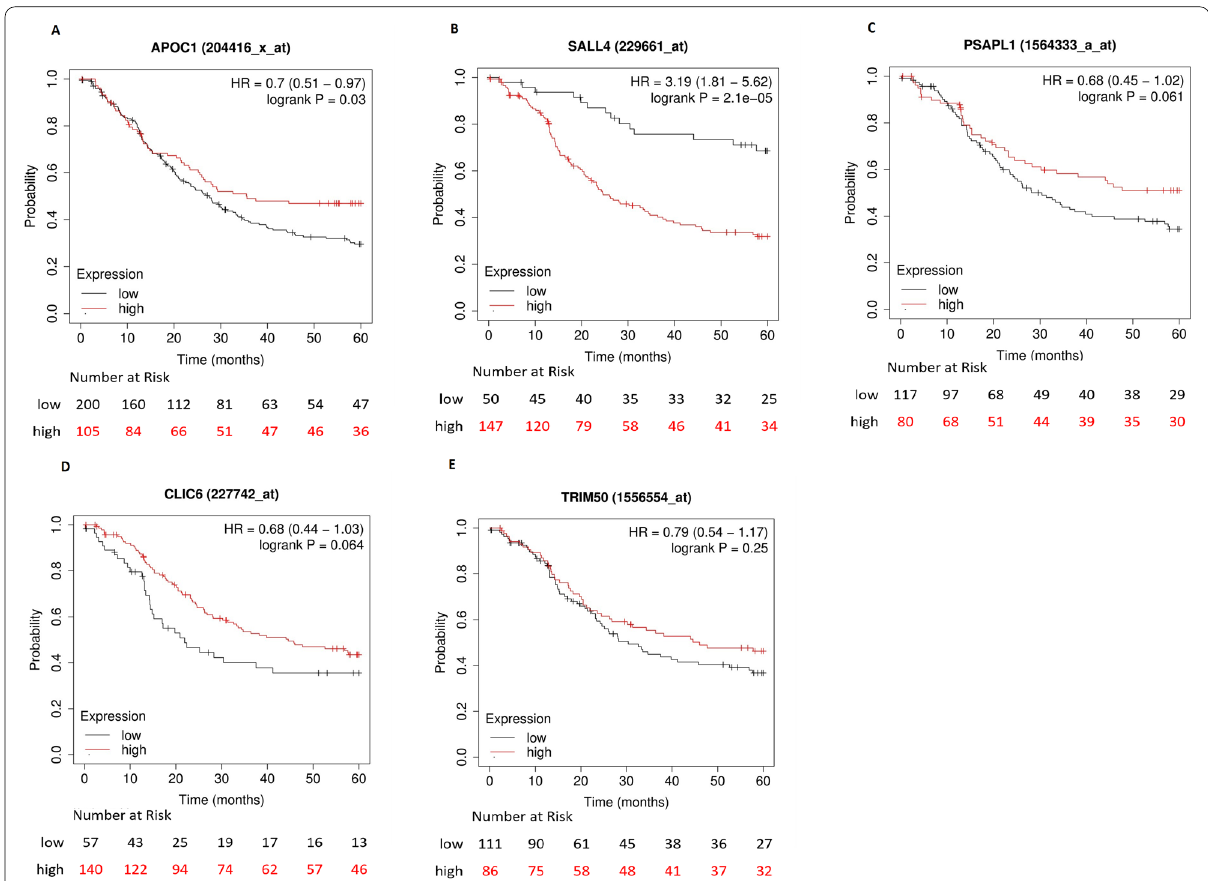
Fig. 3 KM-Plot for the survival analysis using the common genes. A APOC1. B SALL4. C PSAPL1. D CLIC6. E TRIM50. The plots are generated on the basis of the available data on KM-plotter database of 5-year survival data of gastric cancer at stage III. The red plot represents the high expression and